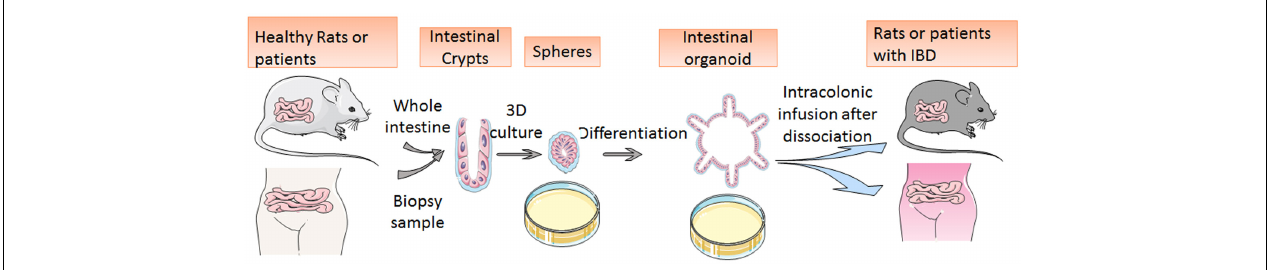
FIGURE 2 | Schematic diagram of mini-gut culture and application to stem cell transplantation. The image shows organoid development from isolated crypts to round spheres and budding organoids. After the cultured and dissociated organoids are transplanted into animal models or human bodies, they spontaneously move toward the damaged focus of the DSS-colitis ulcer and promote reconstruction of the epithelial